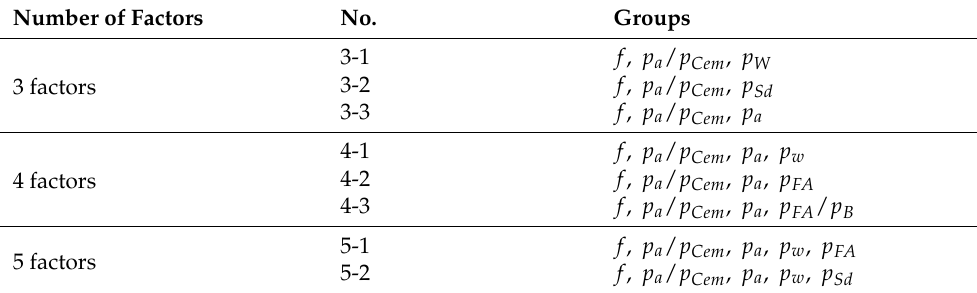
Table 3. Parameter